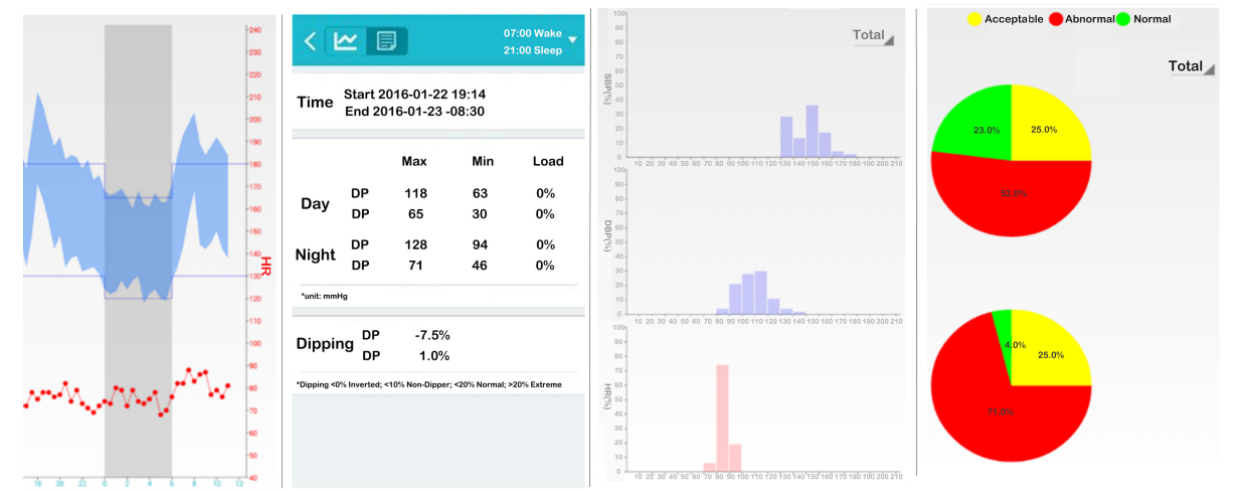
Figure 4. Data analysis and visualization interfaces for app